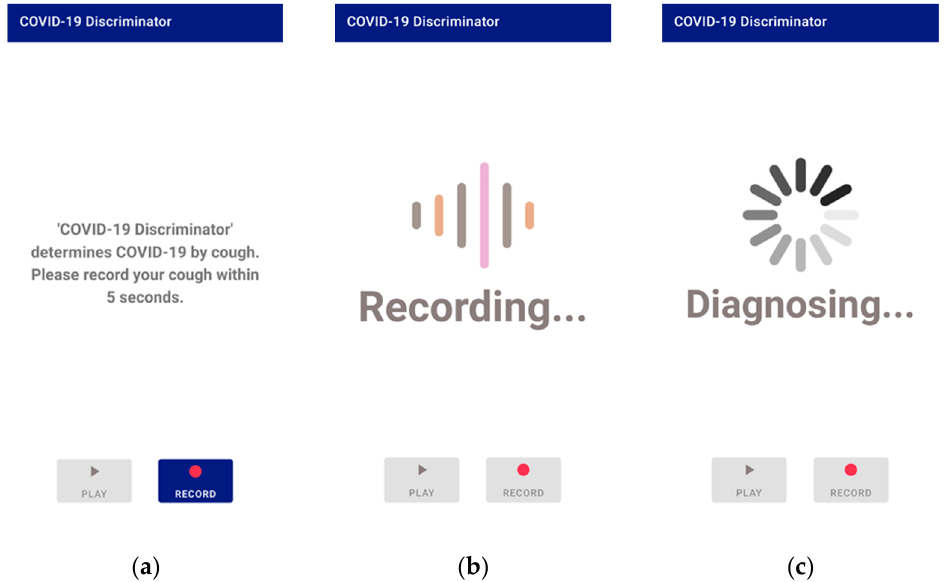
Figure 6. Application screen 1: ( a ) the main screen; ( b ) the screen during recording; ( c ) the screen during processing.